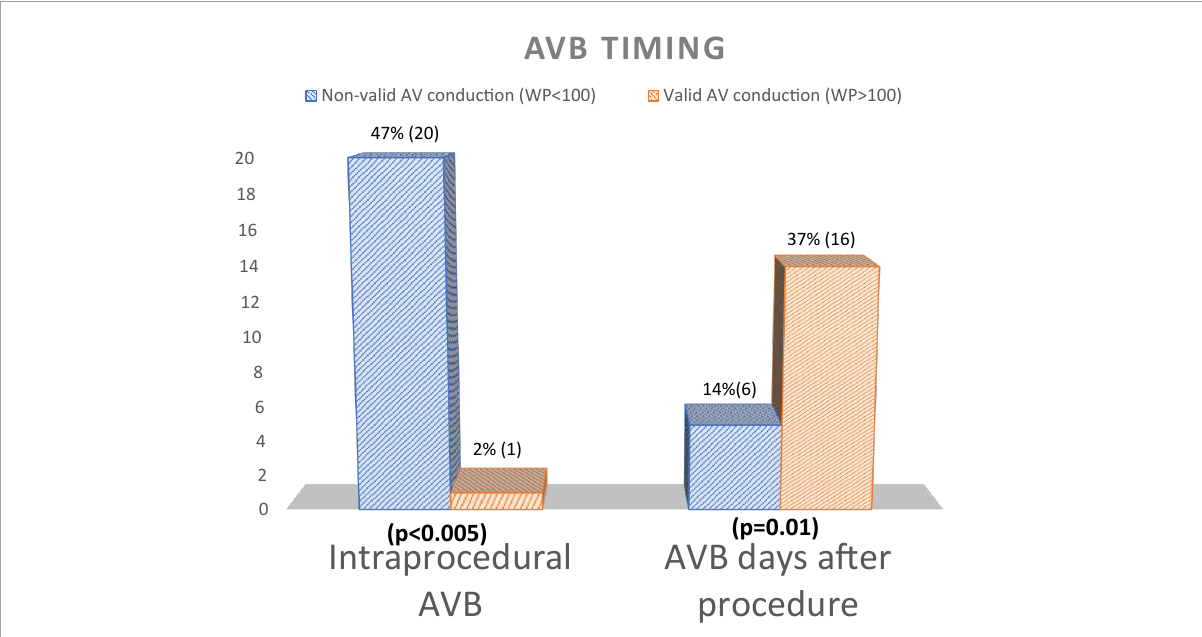
FIGURE3 Atrioventricular block timing differences between patients with and without AV conduction recovery. AV, atrioventricular; WP, Wenckebac point; AVB, atrioventricular block.